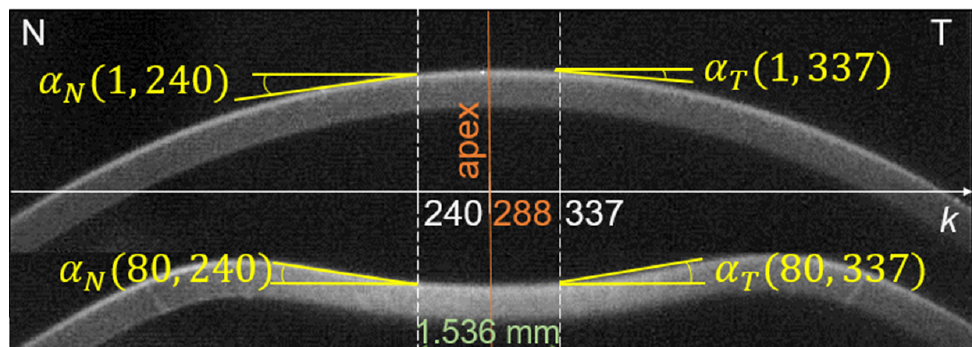
Figure 1. Local slope of the corneal profile α in the image columns k = 240 and 337 (points symmetrical to the apex on the nasal N and temporal T sides) at the beginning of the measurement (top image i = 1) and during the deformation (bottom image i = 80).